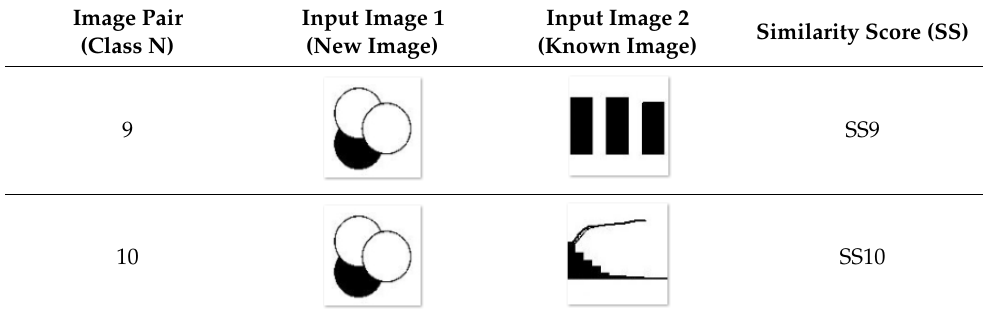
Table 4. Ten-type average classification accuracy. The testing of each architecture is conducted on the same validation set from Table 2. In terms of average accuracy and F-1 score, the Simplified VGG outperforms other networks. Input vs. Random Train Image from Each Class Input vs. Highest Similarity Image from Each Class Simplified VGG Omniglot CNN SigNet